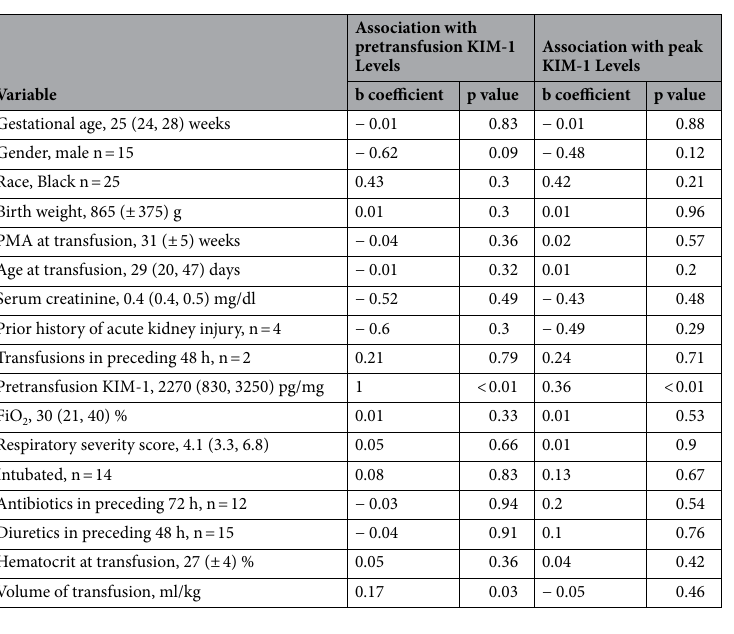
Table 1. Simple linear regression evaluating the association between variables with pretransfusion or peak KIM-1 levels. PMA post menstrual age. Results were presented as mean (± SD) or median (IQR).